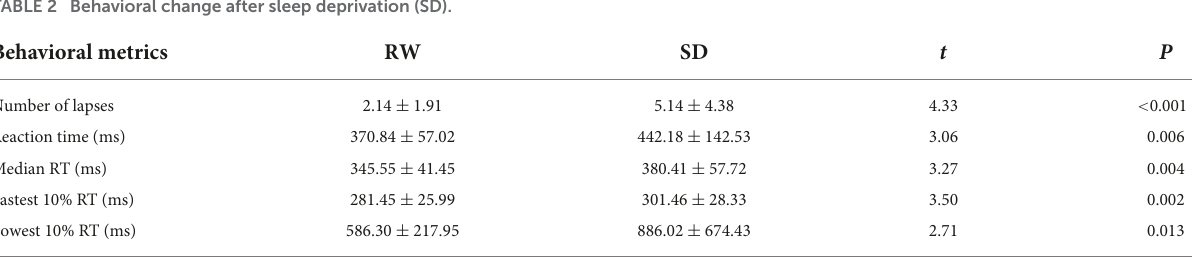
TABLE 2 Behavioral change after sleep deprivation